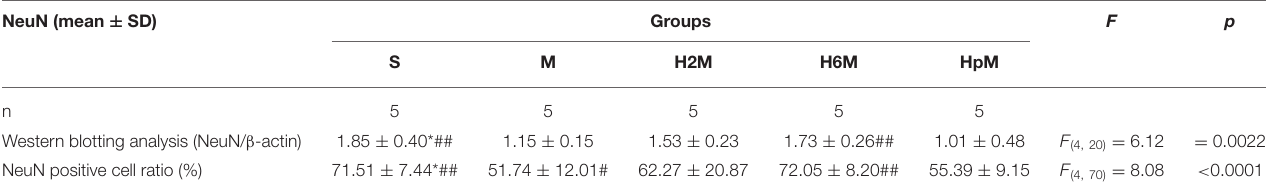
TABLE 2 | NeuN mean gray value analyzed according to western blotting results and positive cell ratio based on immunofluorescence. NeuN (mean ± SD) Groups F p S M